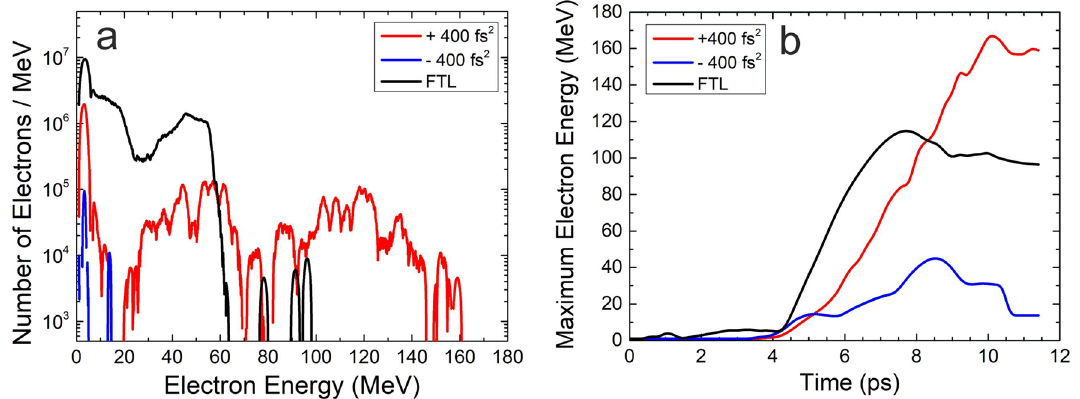
Figure 3. PIC simulation results. ( a ) MeV electron energy spectra for 29 TW laser pulses with positive chirp ( + 400 fs 2 , red solid line), negative chirp ( − 400 fs 2 , blue solid line), and no chirp (FTL, black solid line), interacting with He gas-jet targets. Positively chirped pulses are seen to generate the highest maximum electron energy compared to the negatively chirped and the FTL pulses. This behavior is in qualitative agreement with corresponding experimental results presented in Fig. 2a. ( b ) Temporal evolution of the maximum electron energy for the chirped and FTL laser pulses. Positively chirped pulses show a large energy gain rate that is wider in time, compared to the negatively chirped and FTL pulses, thus resulting in the highest maximum electron